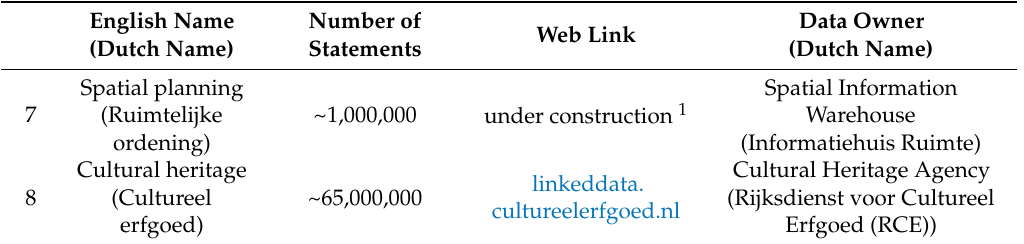
Table 2. KKG data sources that are published in the beta stage. (Source: